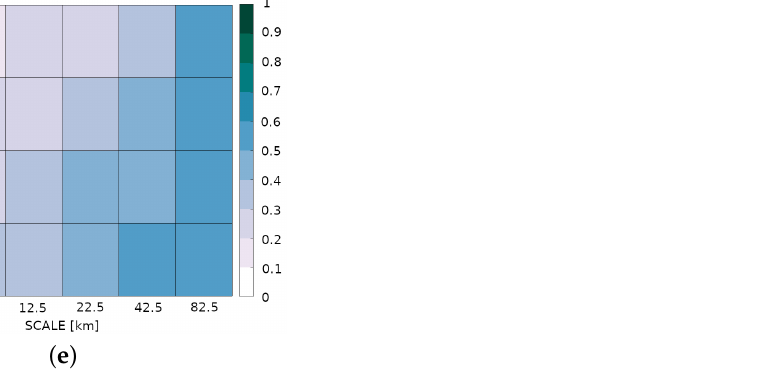
Figure 8. Mean FSS computed in the NW area from 14:00 UTC to 14:55 UTC for CTL ( a ), RDR-LIG ( b ), RDR-ZTD-LIG ( c ), RDR-TMP-LIG ( d ) and ALL ( e ) simulations considering several VIL threshold values: 5 kg m − 2 , 7 kg m − 2 , 10 kg m − 2 and 15 kg m − 2 and different neighborhood sizes: 2.5 km, 7.5 km, 22.5 km, 12.5 km, 42.5 km and 82.5 km,